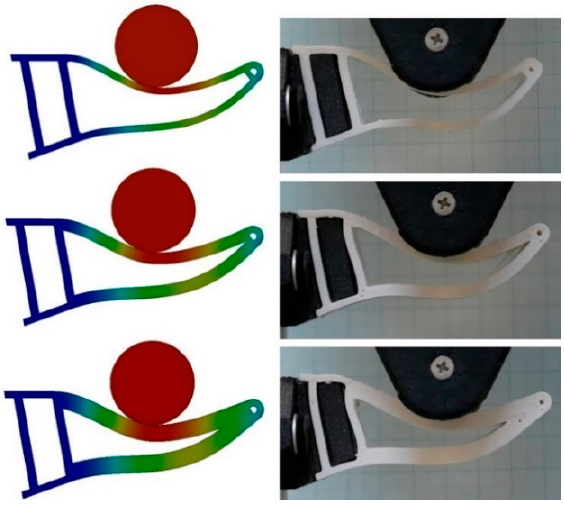
Figure 14. Comparison of the simulation with the printed tested finger of structure B, left: simulation, right: real test, top: wall thickness 1.6 mm, middle: wall thickness 2.8 mm, bottom: wall thickness 4 mm.